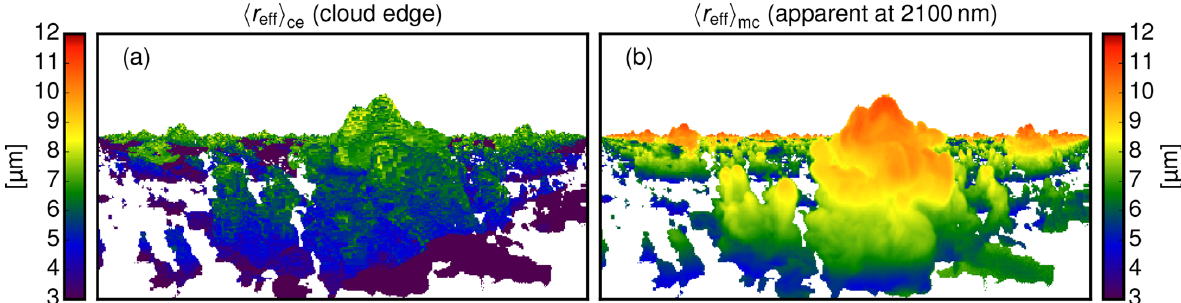
Figure 6. (a) Effective radii r eff found at cloud edge for the scene shown in Fig. 5, (b) apparent effective radii (cid:104) r eff (cid:105) app obtained with MYSTIC REFF for the same